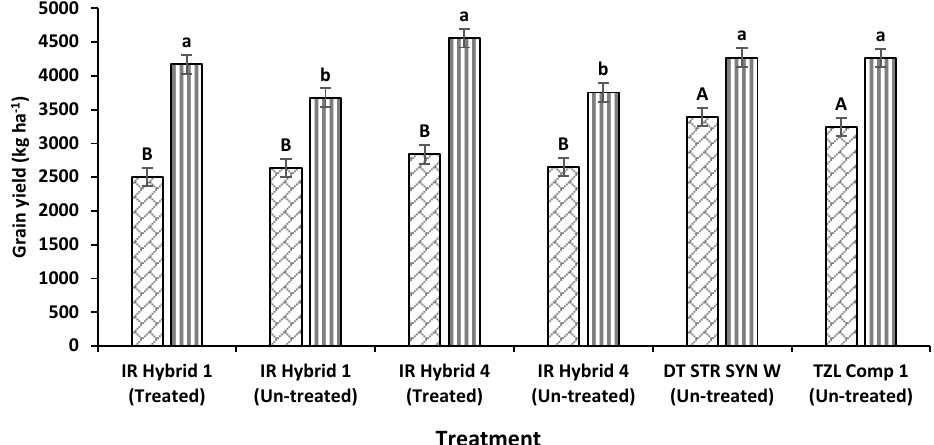
Figure 6. Effect of seed coating of IR maize hybrid with imazapyr on grain yield in farmers’ fields in Kano and Bauchi 2015.